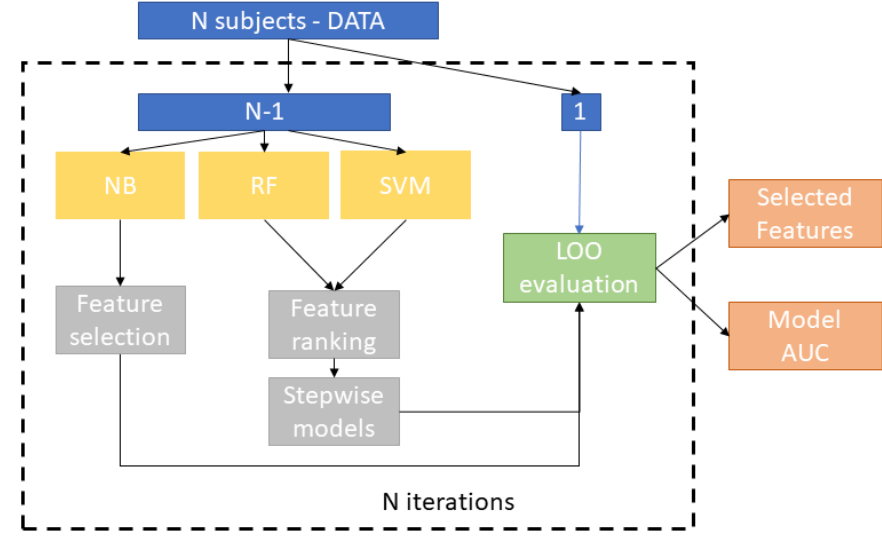
Figure 1. Overview of the machine learning framework.